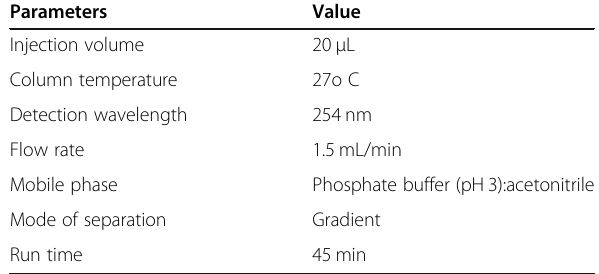
Table 1 Chromatographic conditions of developed method